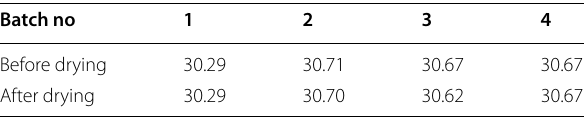
Table 6 Linear shrinkage of the green batches after drying